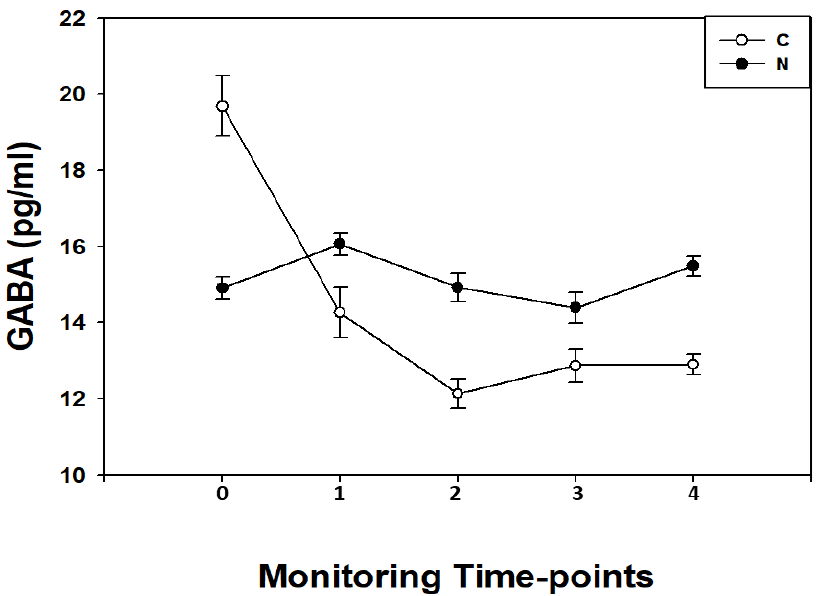
Figure 3. GABA blood concentrations (pg/mL) expressed as median and interquartile ranges in cyanotic (C; o) and non-cyanotic (N; • ) congenital heart disease children measured before the surgical procedure (T0); during the surgical procedure after sternotomy before CPB (T1); at the end CPB (T2); at the end of the surgical procedure (T3), and at 24 h after the surgical procedure (T4). In C GABA levels when compared with N children were higher ( p < 0.001) at T0; no differences ( p > 0.05) at T1; lower ( p < 0.01) at T2; and no differences ( p > 0.05) at T3; lower ( p < 0.01) at T4.